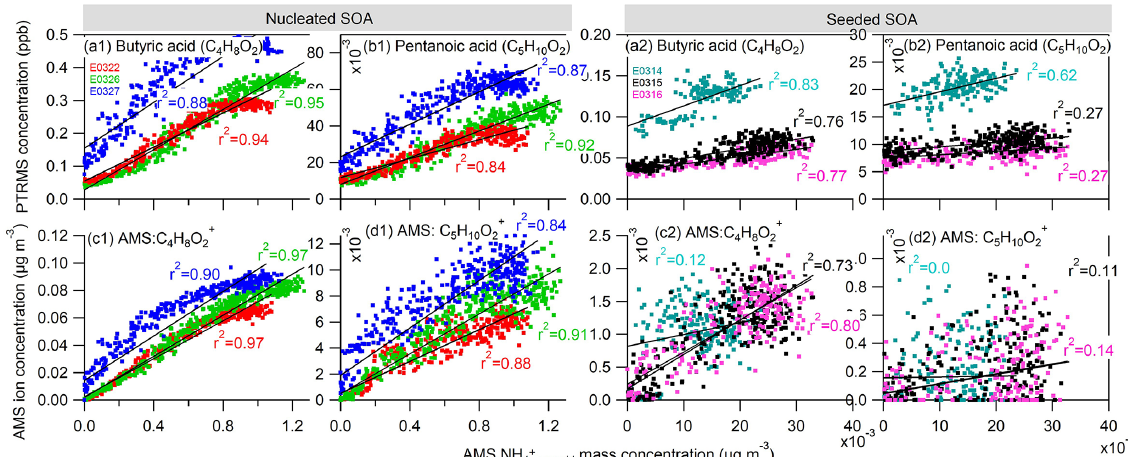
Figure 5. The comparison of measured organic monoacids in the gas phase by PTRMS and the ammonium attributed to the neutralization by organic acids (NH + ) in the particle phase by AMS in the nucleated SOA (a1–d1) and seeded SOA experiments (a2–d2) . (a, b) Linear 4 , orgacid correlation between butyric (C 4 H 8 O 2 ) and pentanoic (C 5 H 10 O 2 ) monoacids measured by PTRMS and the NH + by AMS. (c, d) Linear 4 , orgacid correlation of two fragmental ions C 4 H 8 O + and C 5 H 10 O + to the NH + by AMS. Note that the two fragmental ions have an identical 2 2 4 , orgacid ion molecular formula to those of butyric and pentanoic